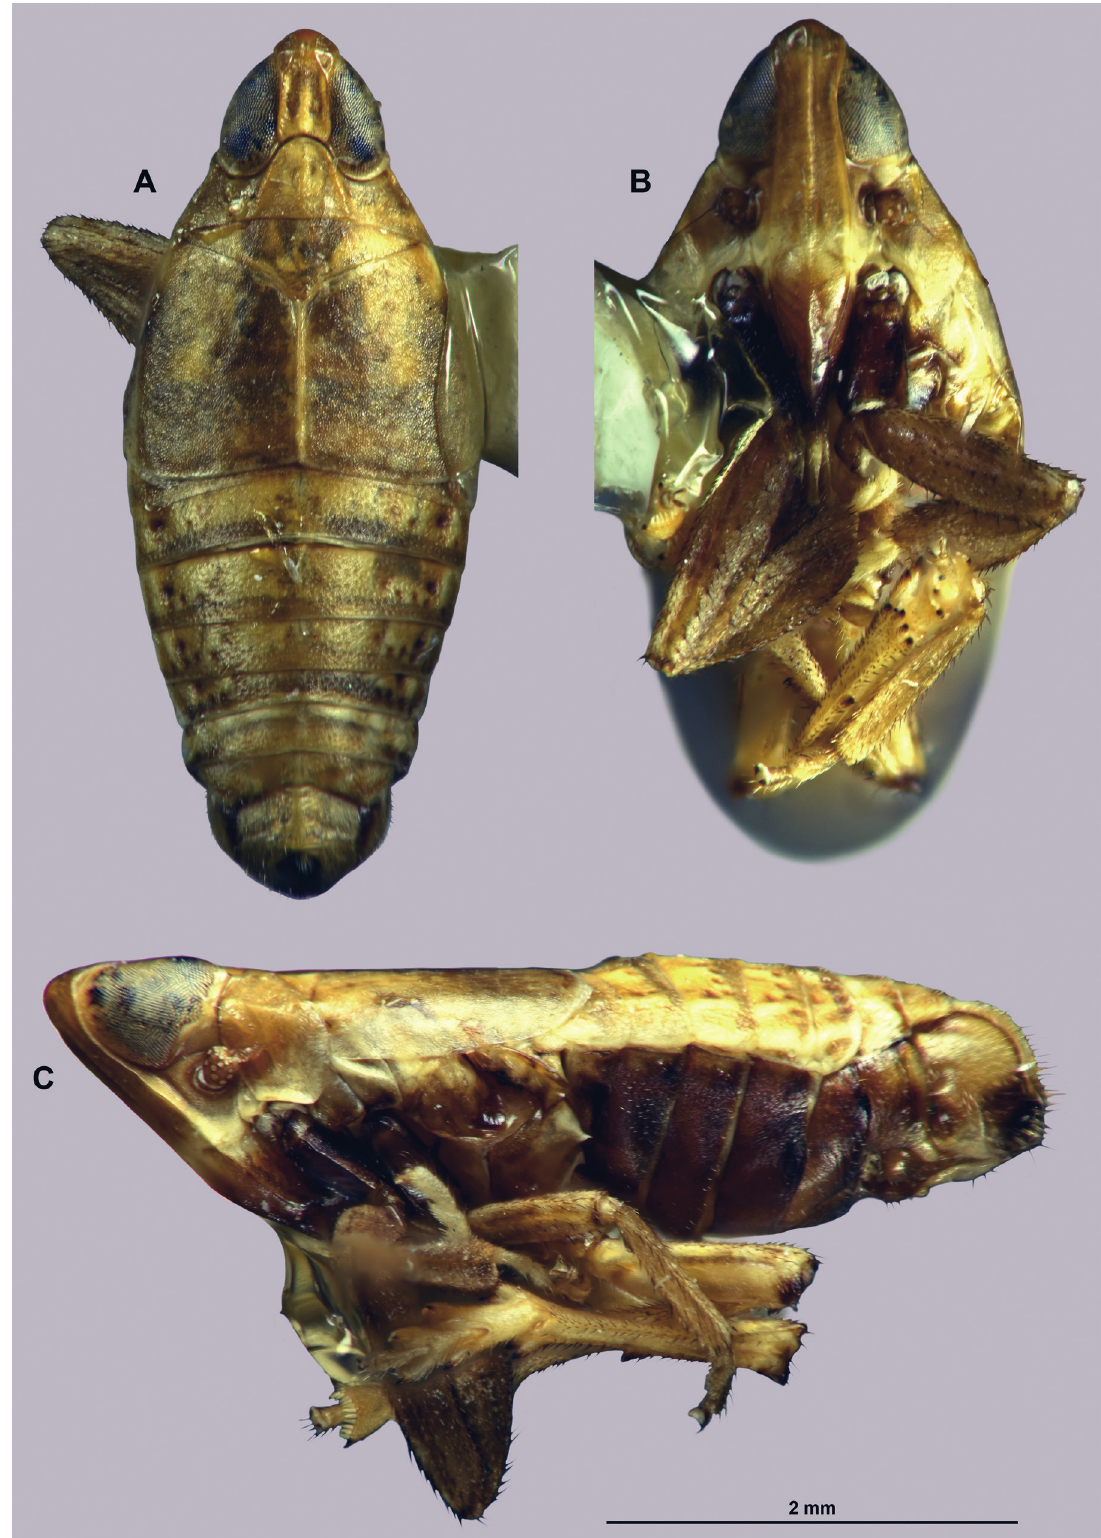
Fig. 16. Cleotyche ( Griseotyche ) blanda Emeljanov, 2011, ♀, holotype (HMNH). A . Habitus dorsal view. B . Habitus, perpendicular view of frons. C . Habitus, lateral view. Photographs: © P.